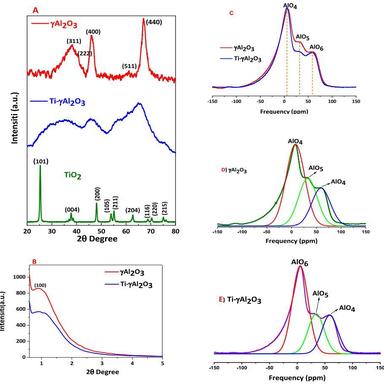
The XRD pattern (A), low-angle XRD pattern (B), 27Al MAS-NMR spectra (C) and their deconvolution results (D and E) of γAl2O3 and Ti-γAl2O3 Xerogel samples.